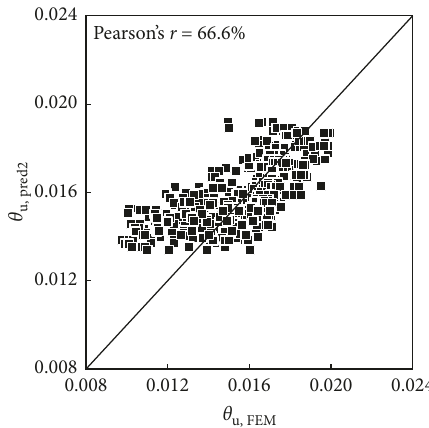
Figure 14: Numerical and predicted ultimate rotation.